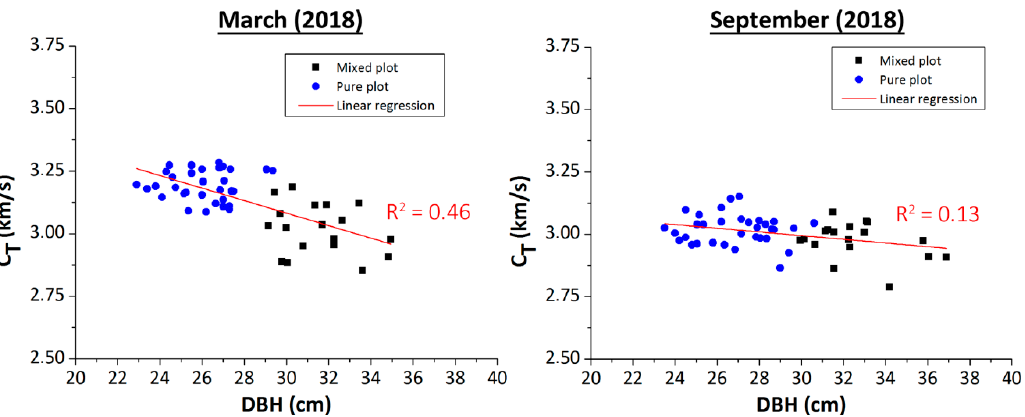
Figure 6. Propagation velocity versus DBH (diameter at breast height) for Plantation 1. Measurements during winter (March, 2018) and summer (September, 2018). Table 2. Average values and standard deviation of DBH and propagation velocity for Plantation 1. Parameters Pure Plot Mixed Plot Pure